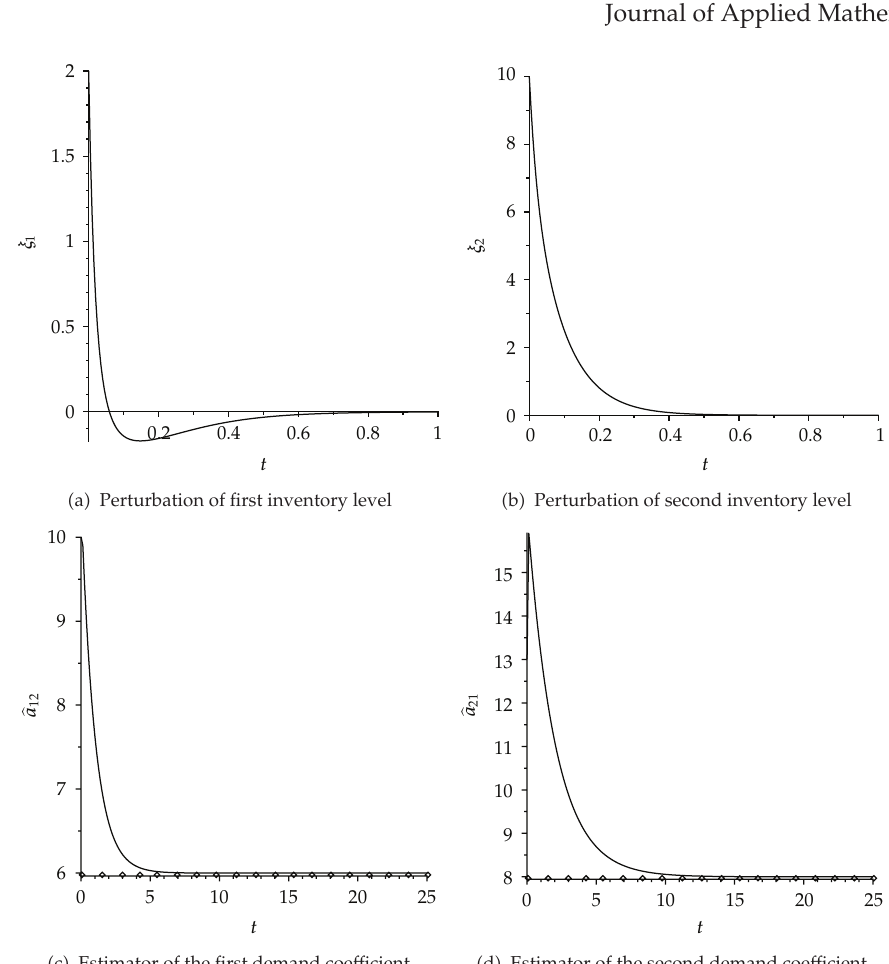
Figure 3: (cid:6) a (cid:7) and (cid:6) b (cid:7) are the perturbation of the first and second inventory levels about their inventory goal levels as the demand rate is a constant. (cid:6) c (cid:7) and (cid:6) d (cid:7) are the di ff erence between dynamic estimators of the first and second demand rates and their real